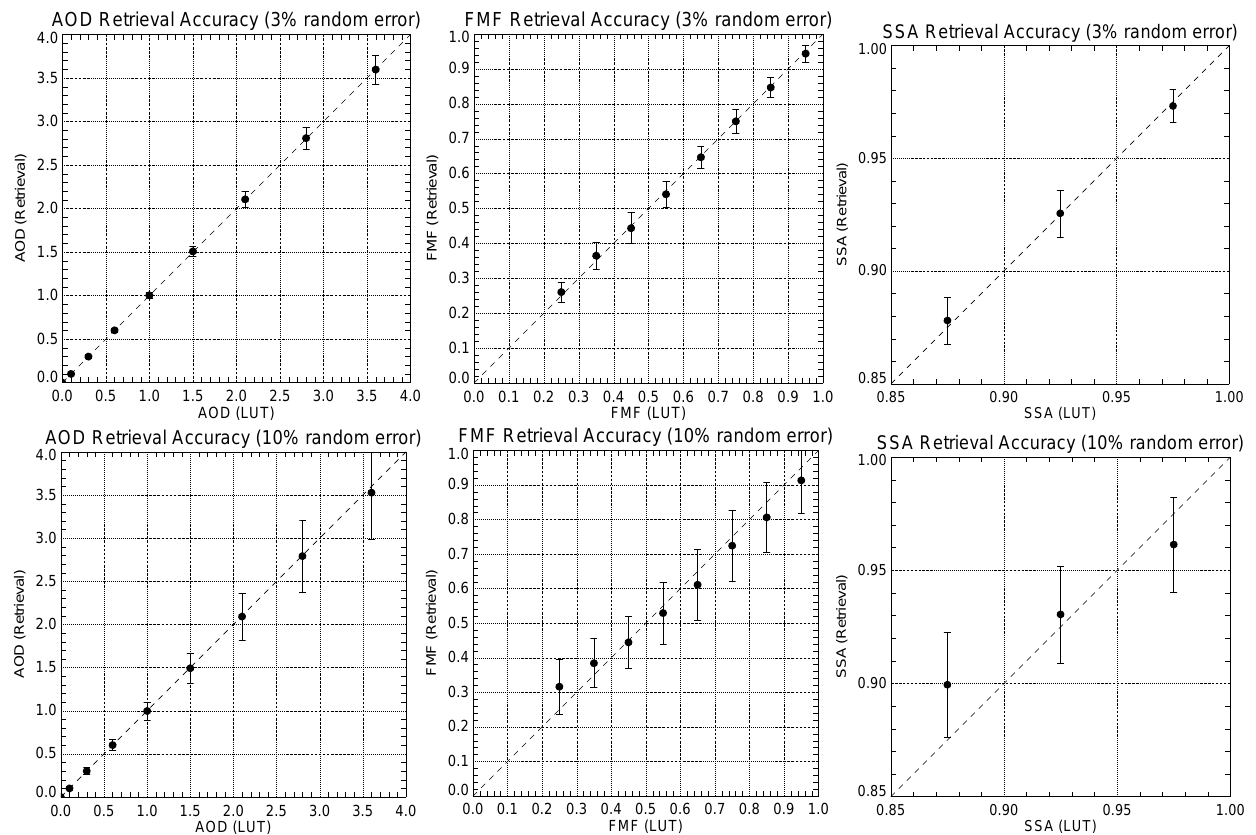
Fig. 5. Comparison between input variables (AOD, FMF, SSA) and retrieved variables from the present algorithm in LUT space. Tests are performed with synthesized data including maximum random error of 3% (upper) and 10% (lower). Mean and standard deviation values are shown for each calculation point for